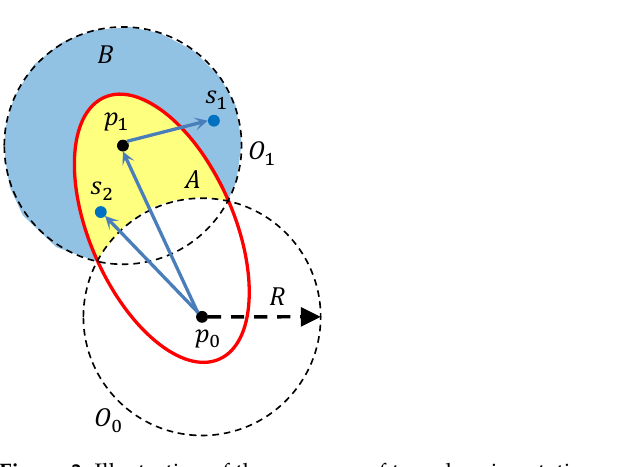
Figure 3. The second one is the part outside the ellipse, denoted by B —see the blue part in Figure 3. By Definition 1, the sites in A are covered by both p 0 and p 1 , while those in B are only covered by p 1 . For the sites in A , according to Definition 2, it is p 0 that serves them, while for those in B , it is p 1 that serves them.